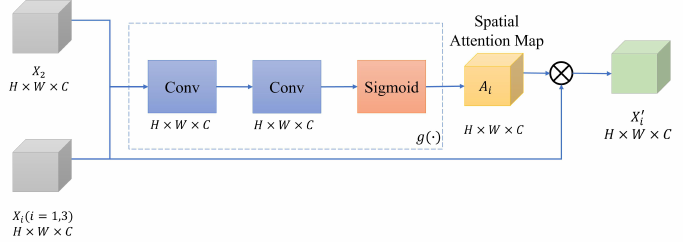
Figure 3. Overview of a spatial attention block.